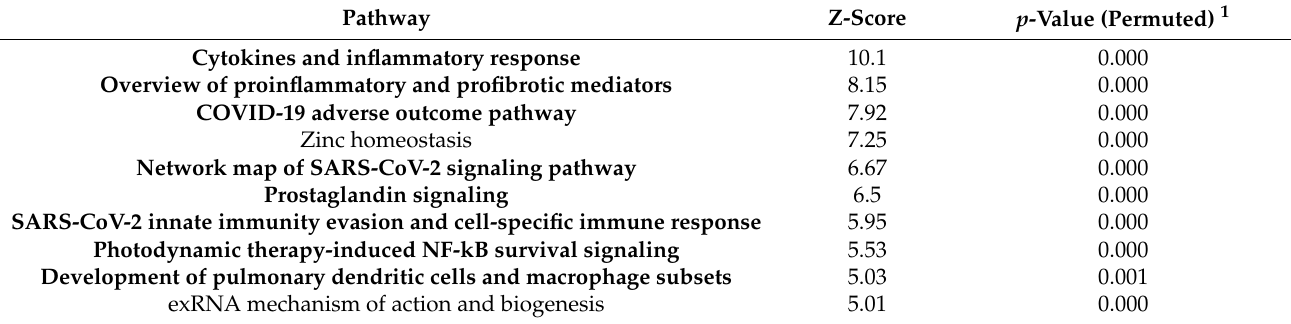
Table 3. Top 10 significant pathways for the Phenion ® Full-Thickness Skin model exposed to Bio- Alcamid ® . DEGs selected by moderated t -test with adjusted p -value < 0.05 were used for ORA in PathVisio. Pathways related to immune and inflammatory response are shown in bold. Pathway p -Value (Permuted) 1